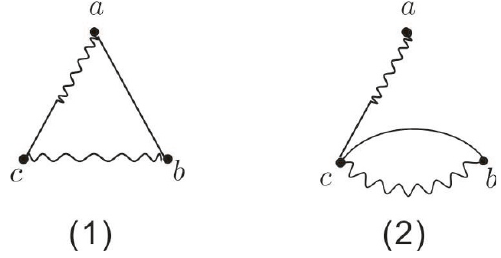
Figure 5 . Diagrams contributing to double pole, which only contain type-2 lines.